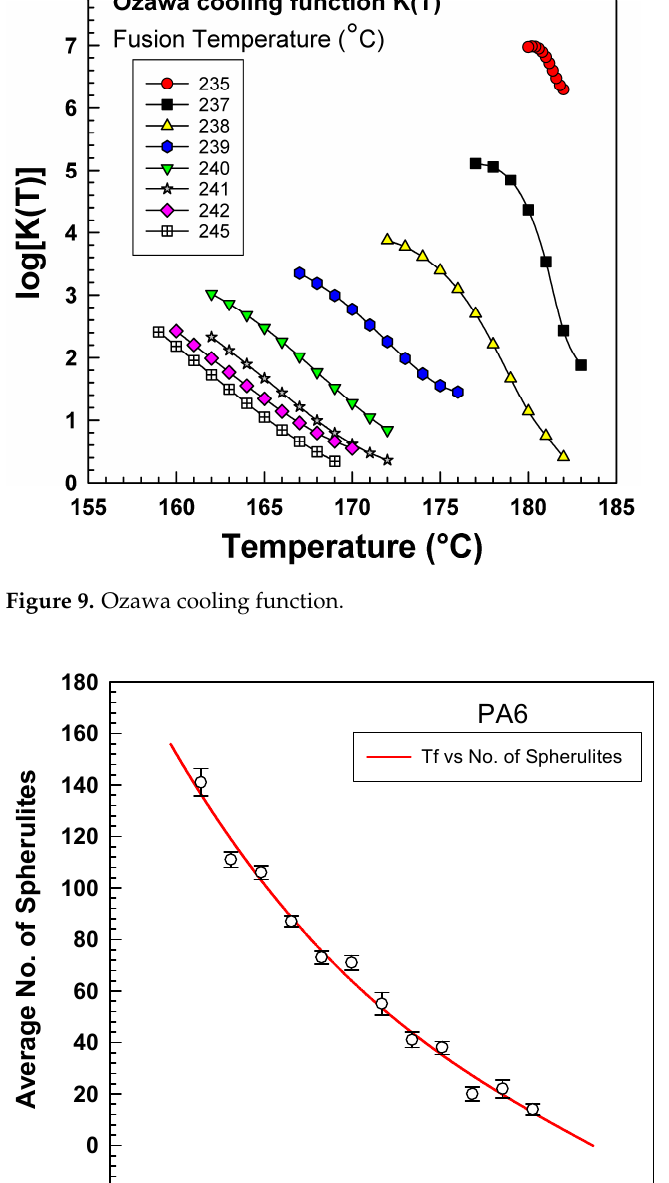
Figure 11. Nonisothermal crystallization by polarized optical microscope at 20 °C/min cooling rate at di ff erent temperatures ( a ) 186.3 °C, ( b ) 183 °C, ( c ) 179.6 °C, ( d ) 176.3 °C, ( e ) 173.8 °C, ( f ) 169.8 °C.